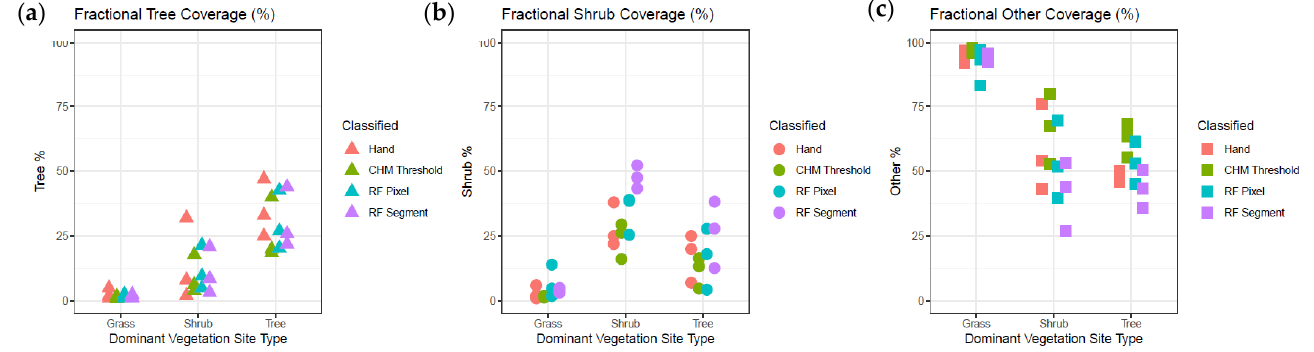
Figure 5. Classification approaches are compared by plotting the site-level FVC estimates from the entire classified image alongside visually hand-classified random points. Vegetation percentages of ( a ) trees, ( b ) shrubs, and ( c ) other by panel, by dominant vegetation site type (columns within each panel), separated by classification technique (color). These results show that, at the site level, estimates of FVC do vary between classifi- cation approaches. The widest range of disagreement between classification approaches occurred for shrub and other coverage estimates. These variations, as indicated in Table 2, were driven primarily by differences in the classification accuracy for shrubs across all sites and were particularly high in shrub-dominated sites. To further refine these differ- ences between the classified output and the by-hand approach, Figure 6 shows the mean relative difference in fractional vegetation cover, estimated by each classified and raster- ized approach, from which the FVC estimated from the random sample of reference points within each study site was subtracted. These differences were aggregated across all sites and site types, yielding a point estimate ( N = 9) and a 95% confidence interval. This yielded statistically significant differences at the α = 0.05 level between any one classification ap- proach and the by-hand estimates in FVC when the CI did not overlap zero.